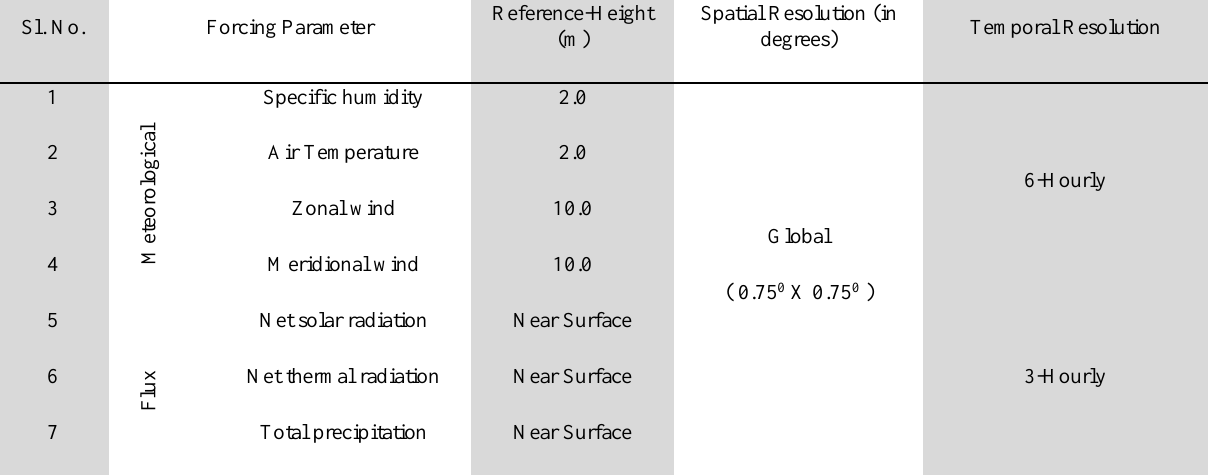
Table 1: ERA-Interim Forcing